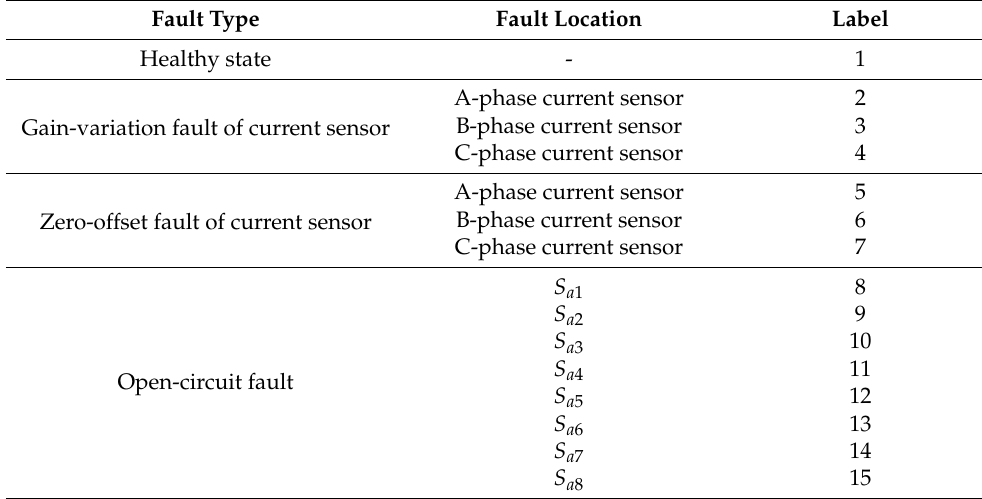
Table 3. Labeling of the faults.